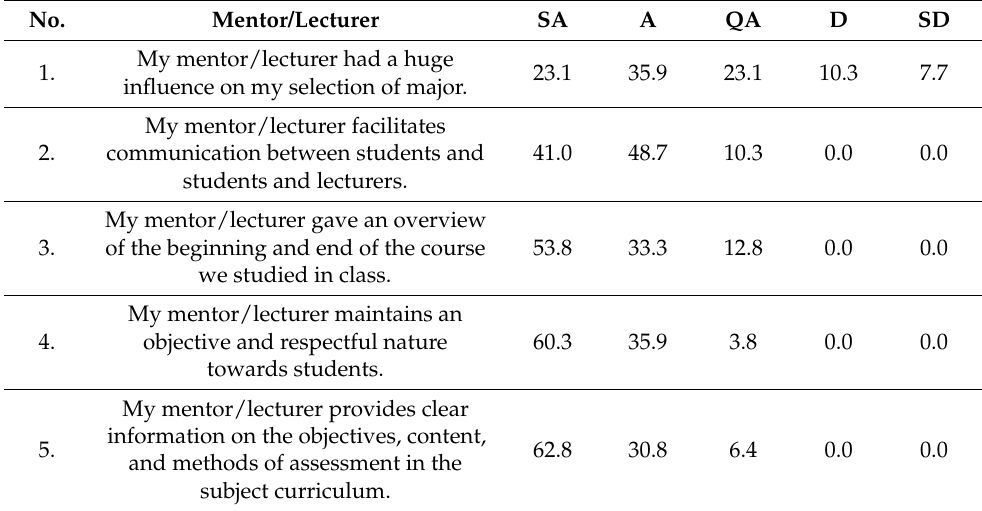
Table 5. Influence of Mentor/Lecturer.